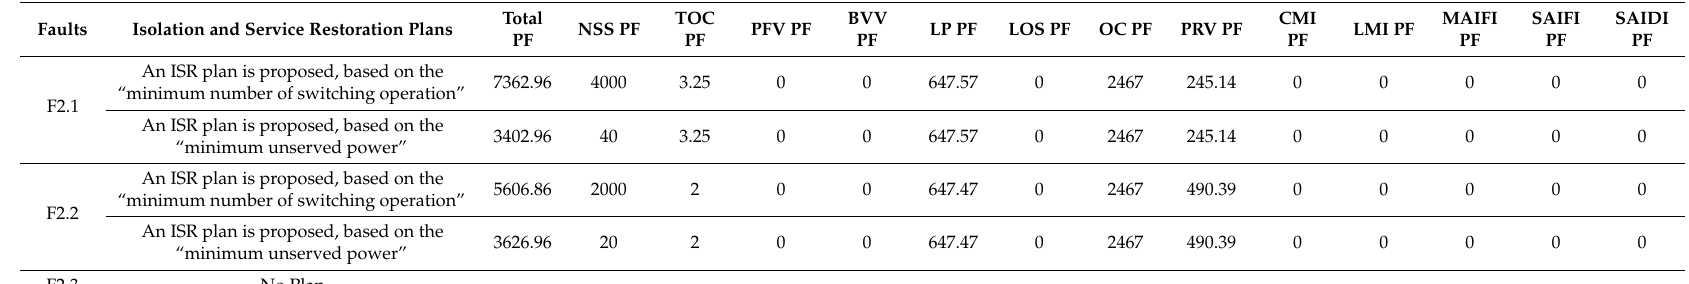
Table 24. Performance factors for each ISR plan at F2.